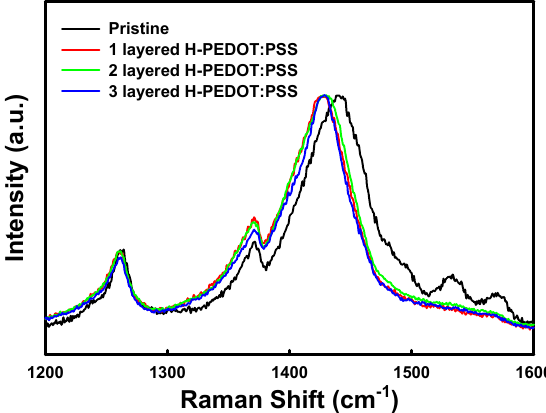
Figure 2. ( a ) XPS of the pristine PEDOT:PSS film and PEDOT:PSS films with sulfuric acid etching treatment and XPS depth profile etching by argon ion of ( b ) the pristine PEDOT:PSS thin film and ( c ) three-layered H-PEDOT:PSS thin film.